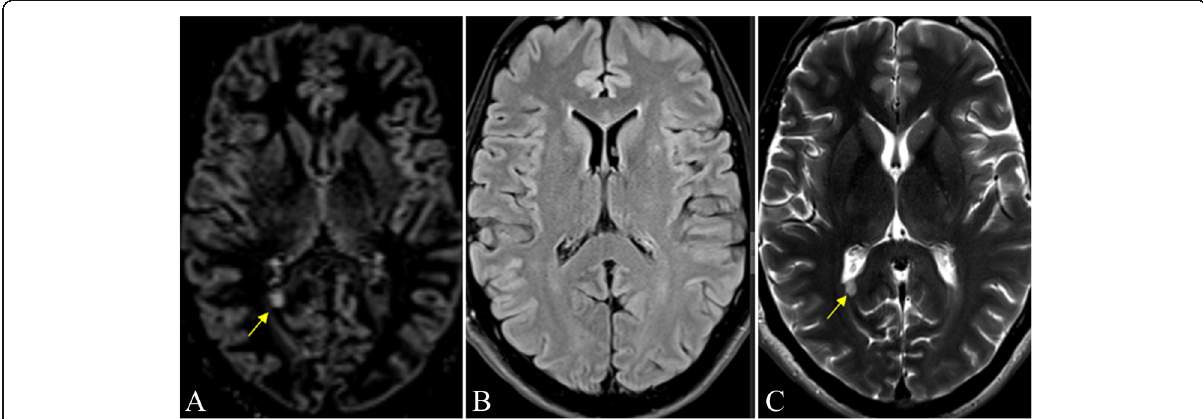
Fig. 2 Axial MRI of the brain. A lesion (arrow) with higher signal intensity and greater contrast and enables improved visualization of the lesion in DIR ( a ) and T2WI ( c ) and not seen in FLAIR ( b )